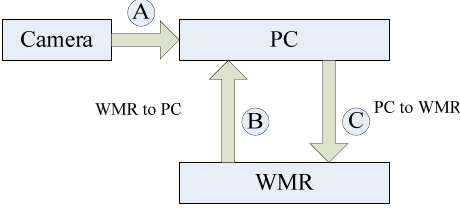
Figure 14. Schematic diagram for personal computer (PC) connection.